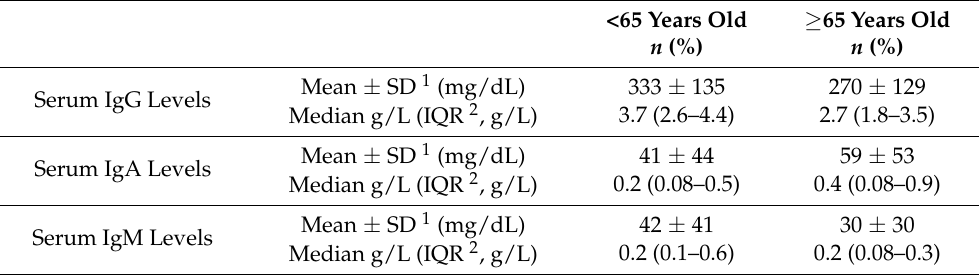
Table 2. Serum immunoglobulin levels (mg/dl and g/L) at diagnosis in 78 younger and older CVID